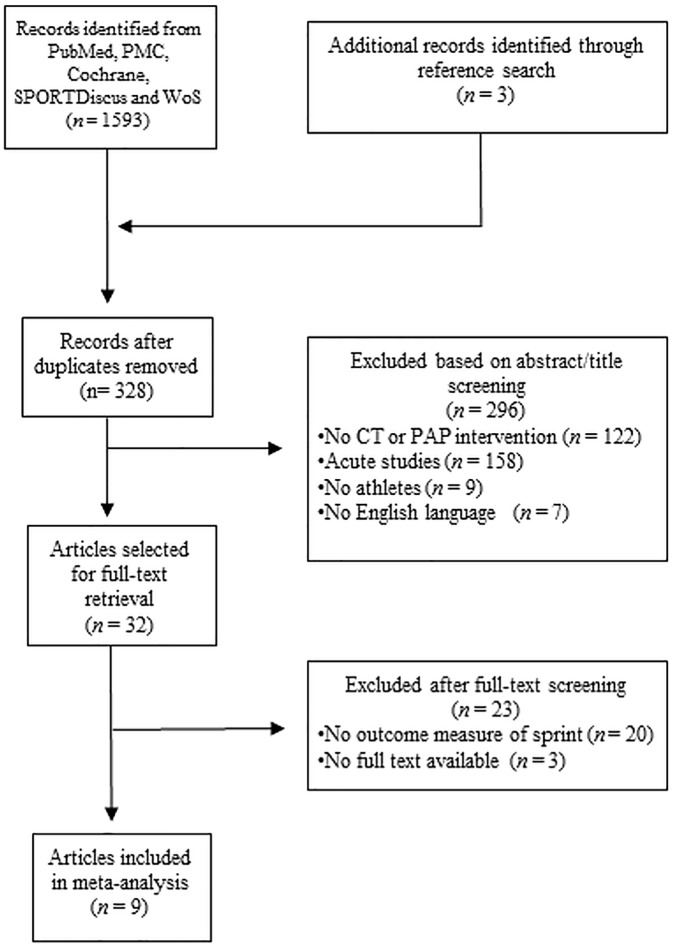
Flow diagram of the process of study selection.